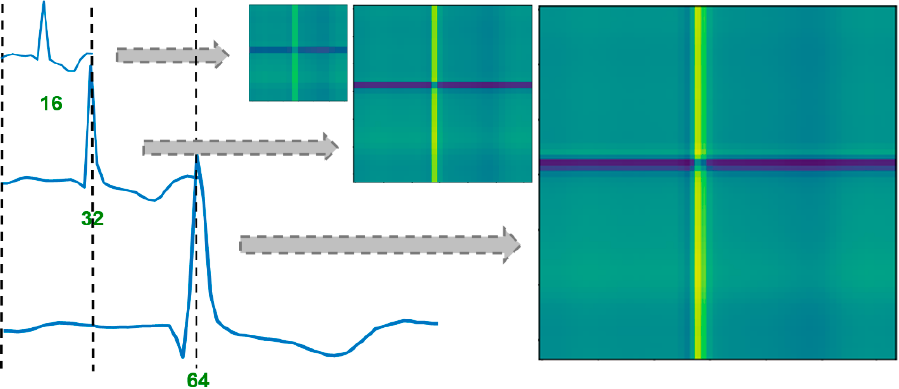
Figure 3. The effect of ECG length on the GADF image; the image generated from a longer ECG captures fine-grained patterns of the signal, and the image generated from a shorter ECG (length reduced using PAA) captures coarse-grained patterns.